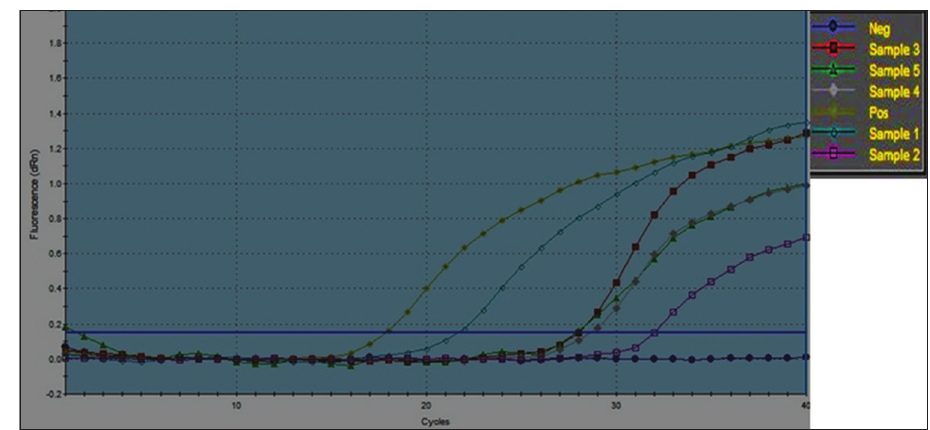
Figure-2: Amplification curves of real time-quantitative polymerase chain reaction for quantification of Brucella vaccine batches. Sample 1=RB51 vaccine, sample 2=Rev-1 vaccine, sample 3=RB51 vaccine, sample 4=S19 vaccine and sample 5=S19